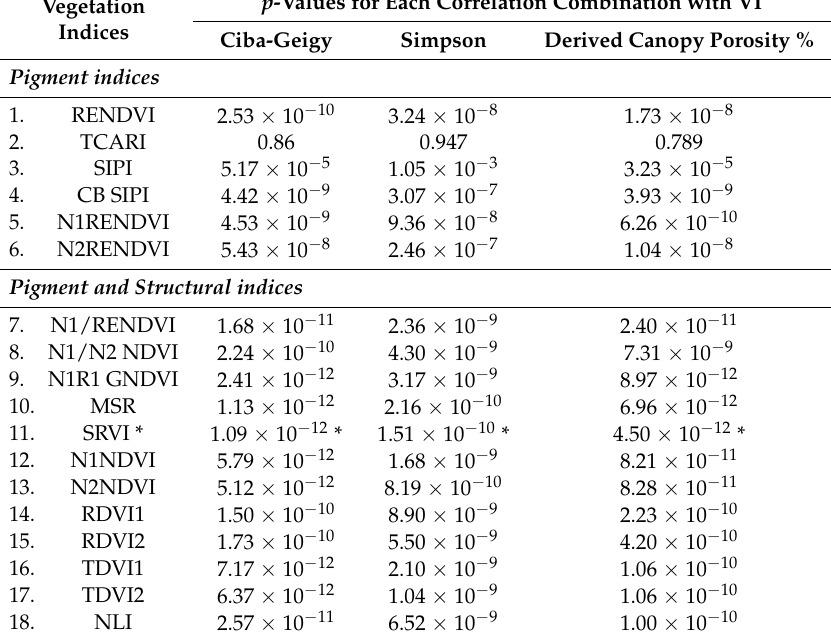
Table 4. Significance of vegetation indices correlating with visual disease rankings and derived canopy porosity from stepwise regression analysis.